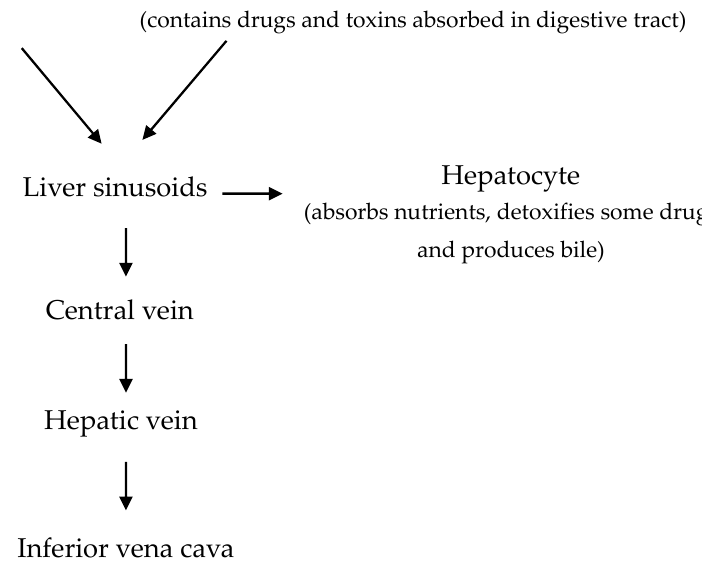
Figure 1. Blood flow through the liver lobule (Adapted from Akers and Denbow [5]).